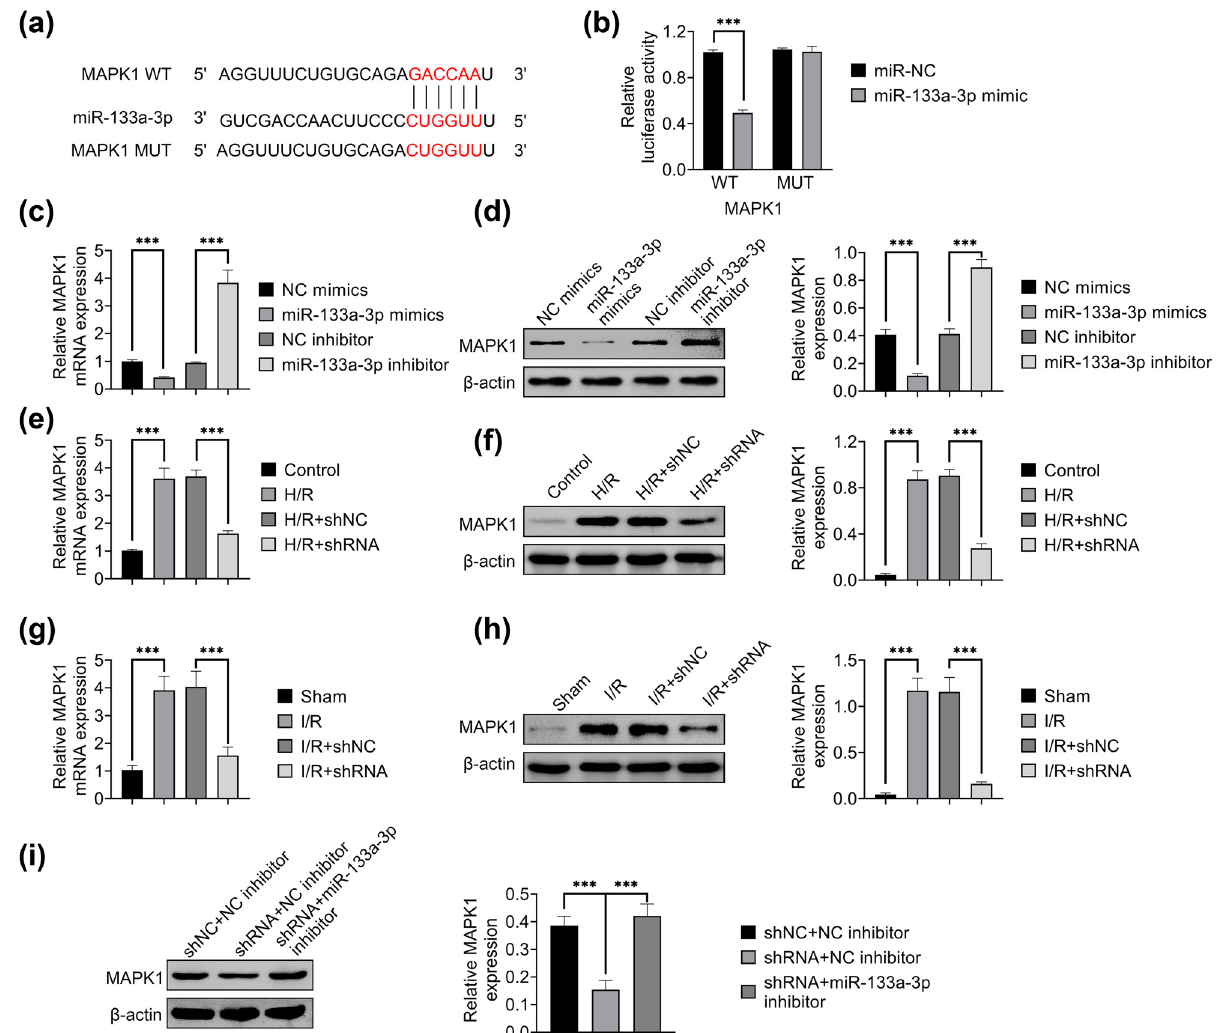
Figure 4: HAGLR modulated MAPK1 expression by targeting miR - 133a - 3p. ( a ) The binding site of miR - 133a - 3p to MAPK1 was predicted